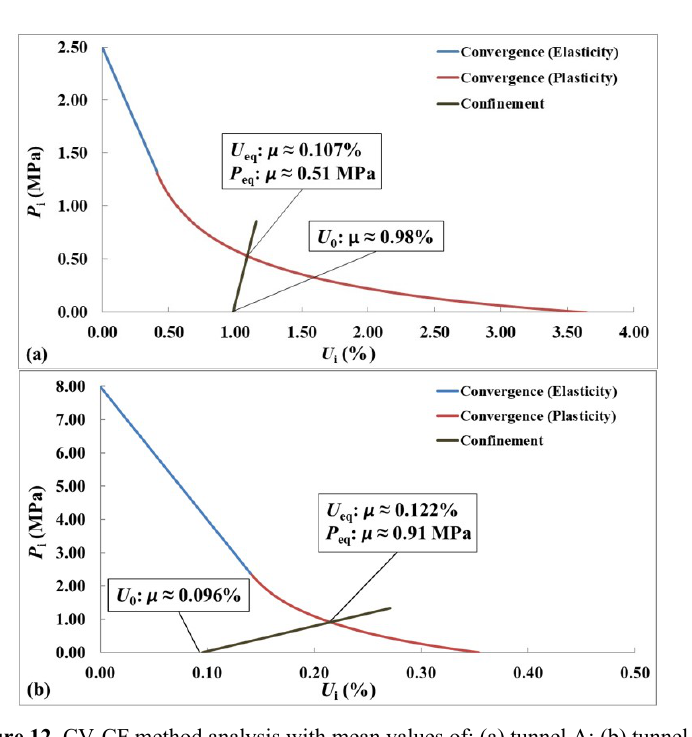
Figure 12. CV-CF method analysis with mean values of: (a) tunnel A; (b) tunnel